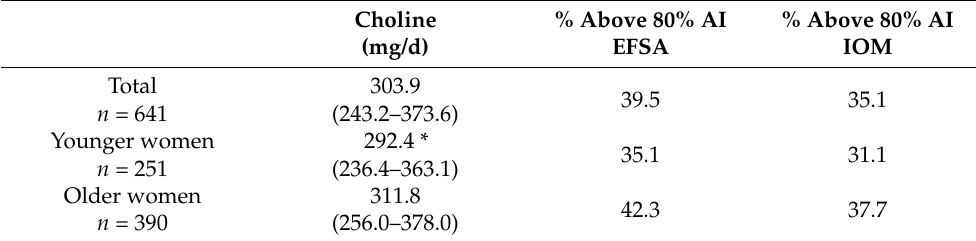
Table 3. Choline intake and prevalence of adequacy (percentage of population above 80% AI) in women of childbearing age from the ANIBES study.